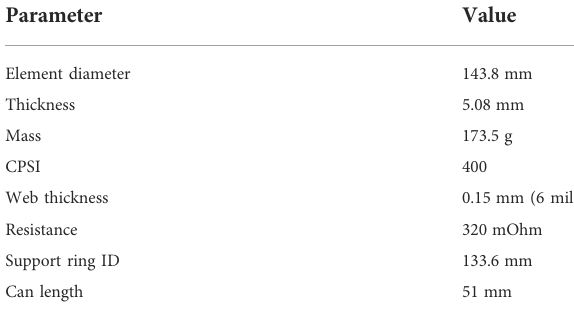
TABLE 1 Catalyst heater speci fi